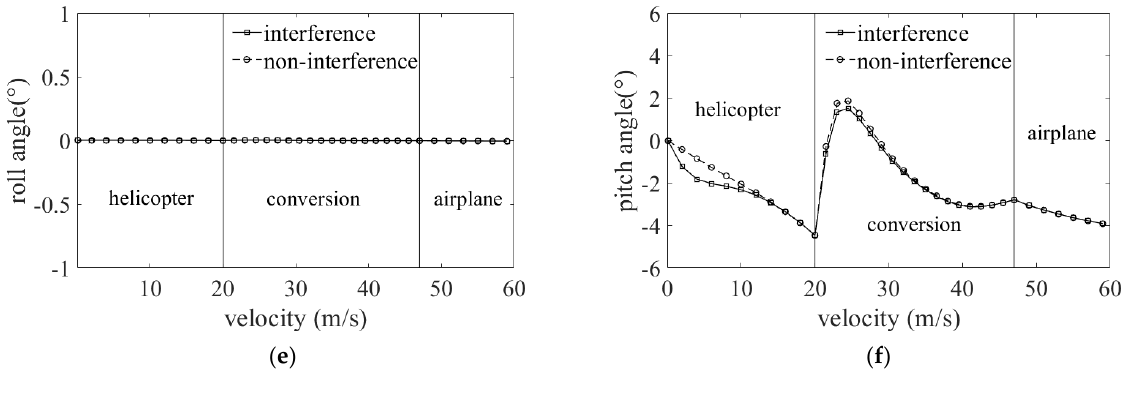
Figure 11. Comparison of trim results with and without total interference. ( a ) Comparison of collec- tive stick displacement with and without interference. ( b ) Comparison of lateral stick displacement with and without interference. ( c ) Comparison of longitudinal stick displacement with and without interference. ( d ) Comparison of heading stick displacement with and without interference. ( e ) Com- parison of rolling angle with and without interference. ( f ) Comparison of pitching angle with and without interference.